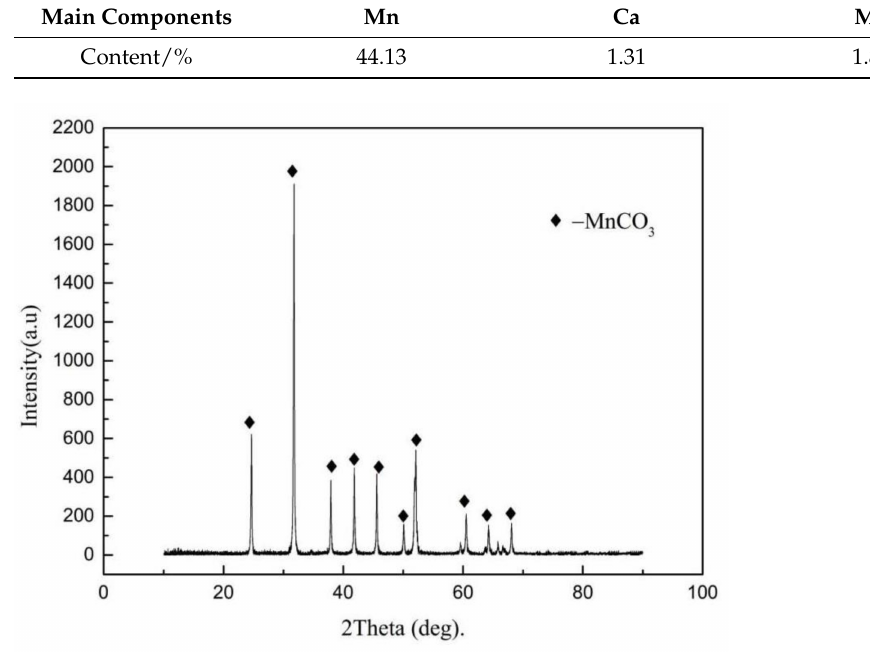
Figure 6. XRD of manganese carbonate in ammonia vapor